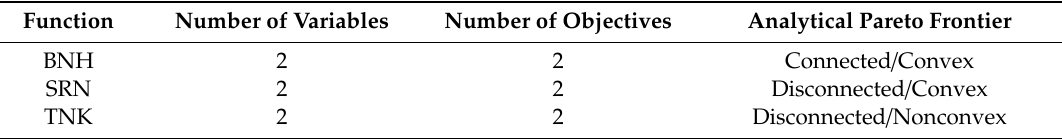
Table 1. Bi-objective optimization